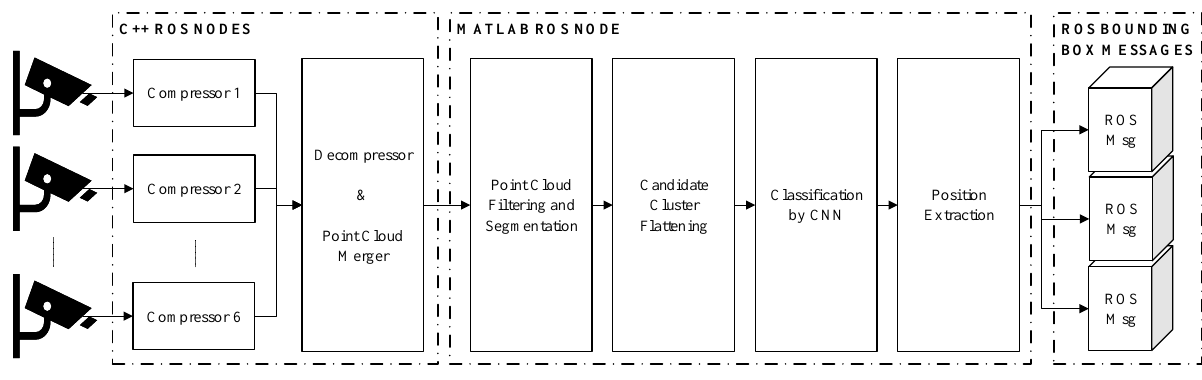
Figure 1: Flowchart of the people detection system. The point clouds from each sensor is compressed by an edge computer, and received by a centralized computer before being decompressed and